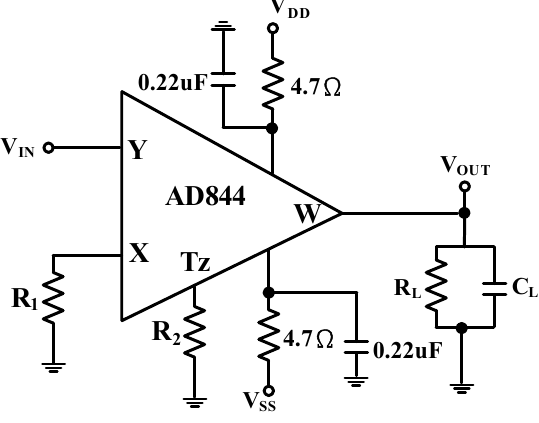
Figure 13. Tested frequency range of AD844.